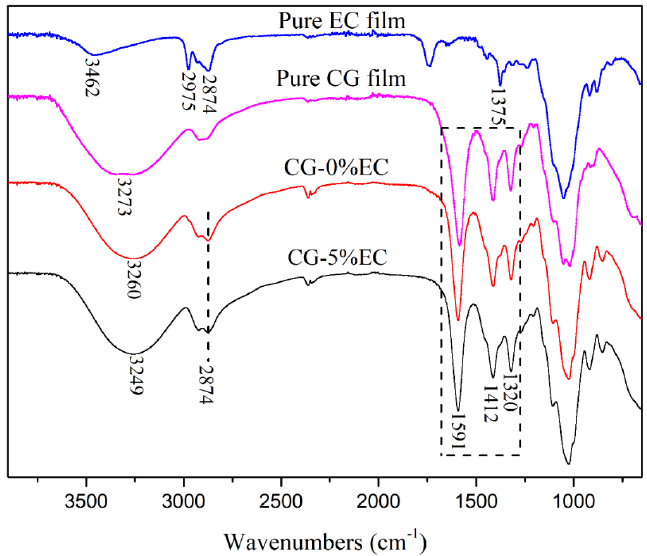
Figure 1. FTIR spectra of pure CG film, pure EC film and CG/EC films.